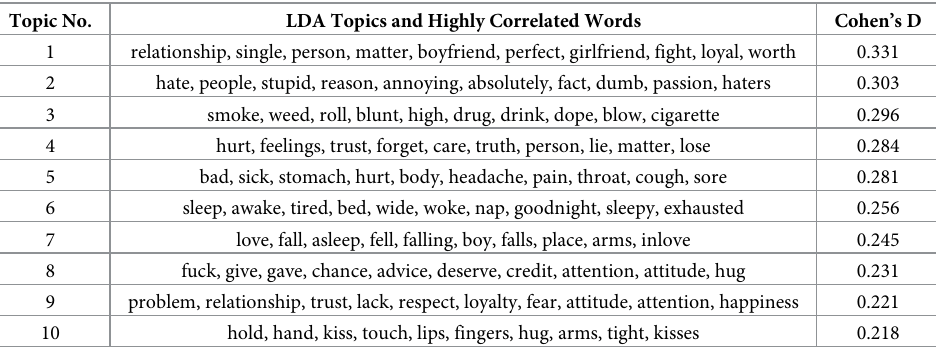
Table 5. Results from LDA analysis for gender: Male. Topic No.